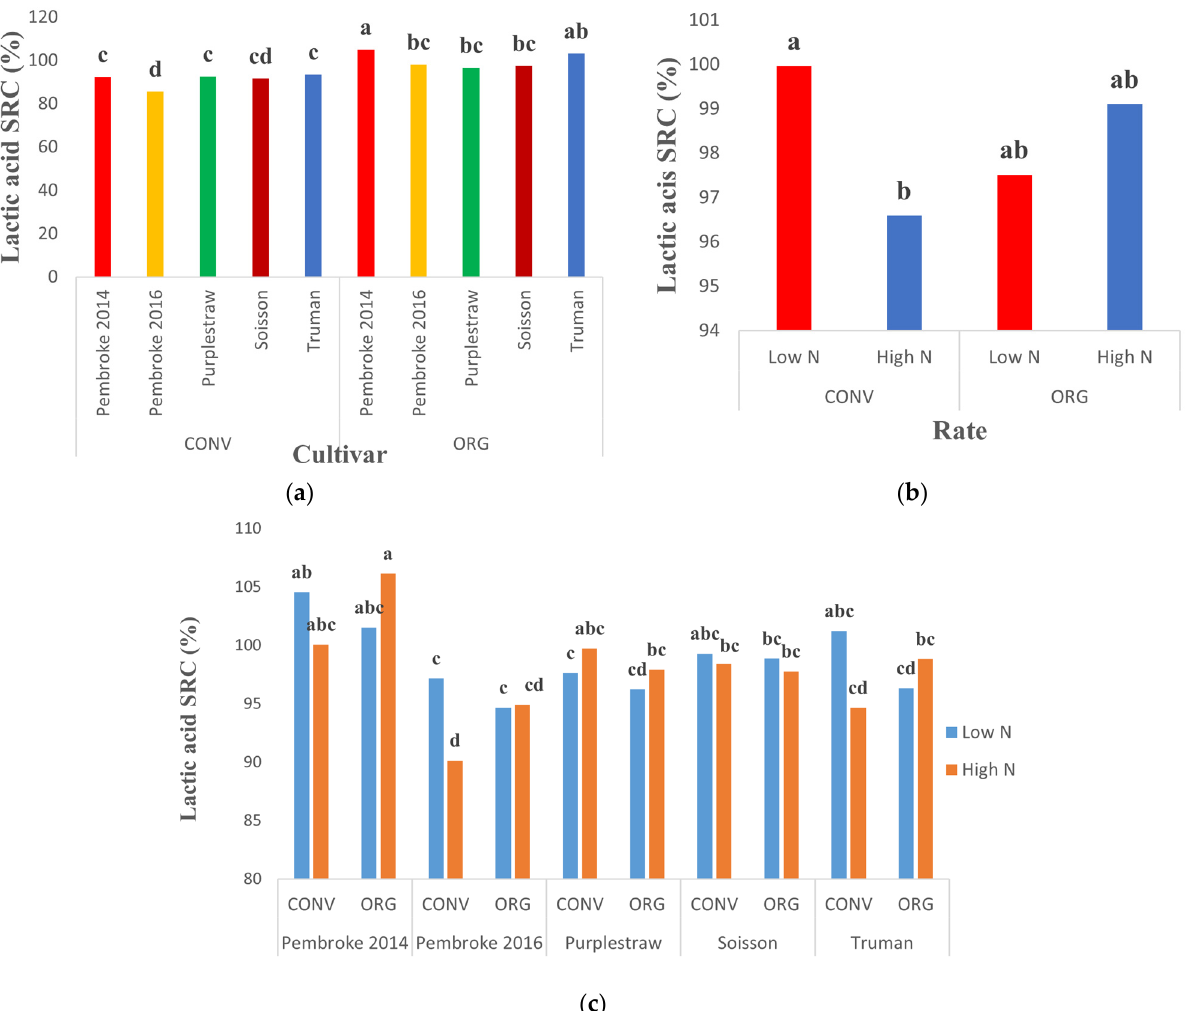
Figure 4. Gluten strength as measured by lactic acid solvent retention capacity (SRC) as affected by production system by cultivar in Y1( a ), system by N fertilization rate in Y2 ( b ) and system by N fertilization rate by cultivar in Y2 ( c ). Bars with the same letters within each figure are not significantly different based on Tukey’s honest significant difference (HSD) test performed at α = 0.05.